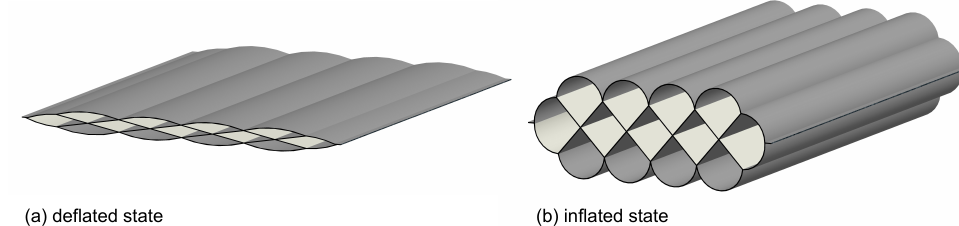
Figure 5. Cuboid conformal-woven pressurized structure in deflated ( a ) and inflated ( b )